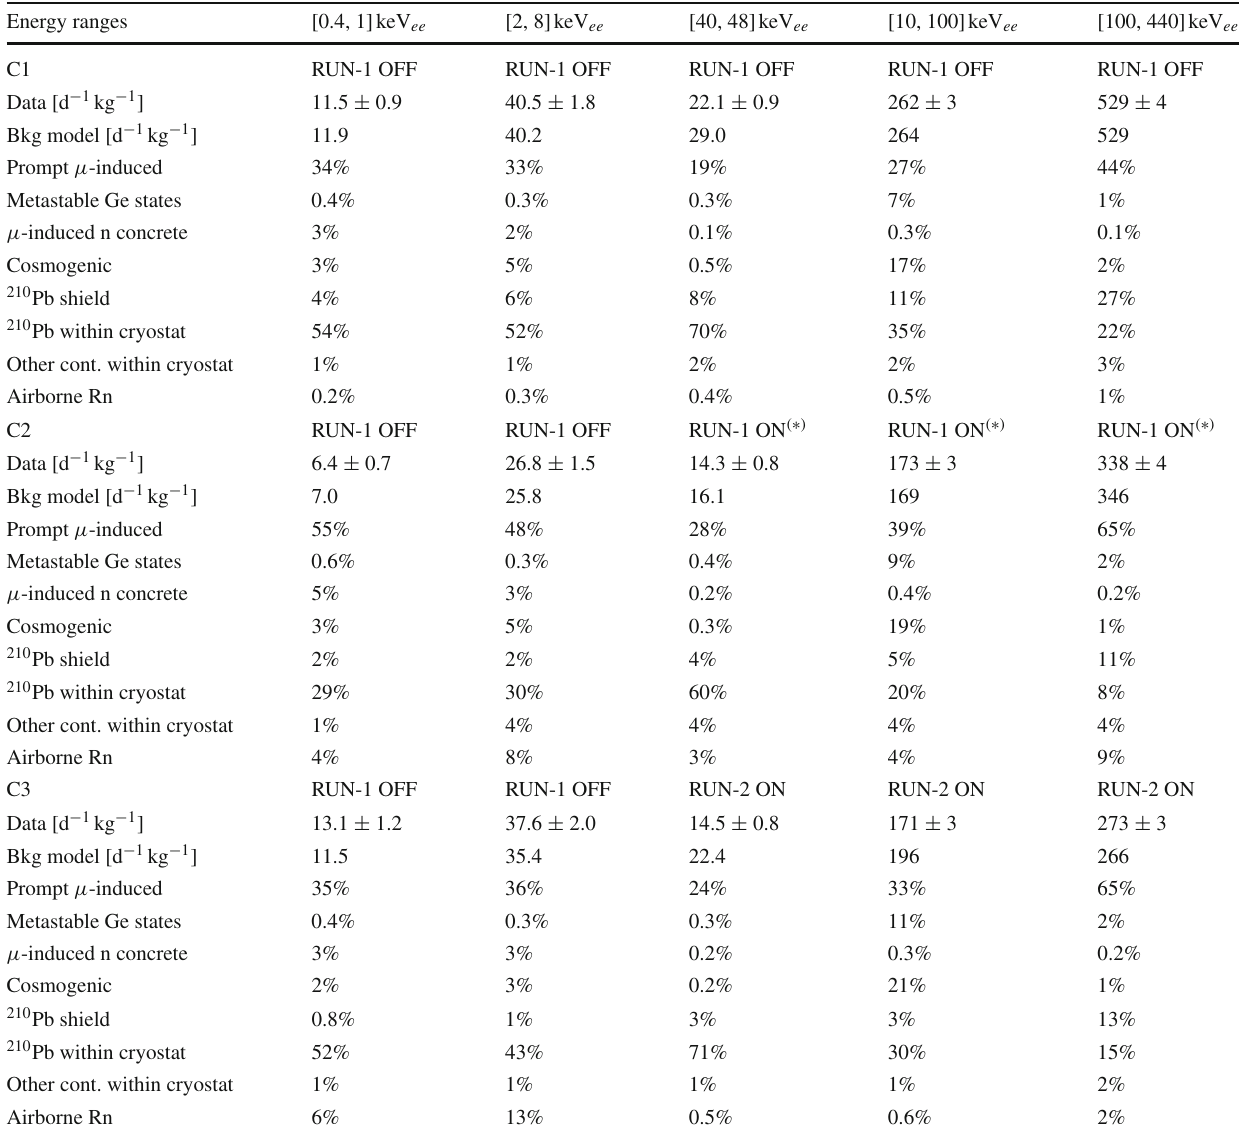
in each energy range. If available, reactor OFF data are used for the comparison to the MC. This is not always the case for the highE range. ( ( ∗ ) data collected in optimization phase after